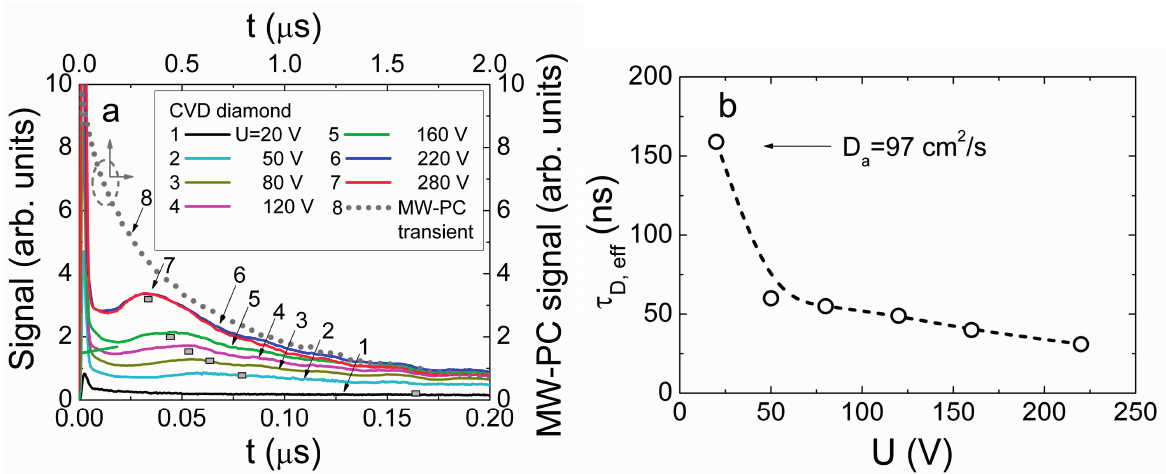
Figure 13. ( a ) Variation of the current transients recorded in the CVD diamond device by changing bias voltage when excess carrier bulk domain is injected through electrode using UV 354 nm light pulses. Dot-curve, ascribed to the top-right scales, represents relaxation of excess carrier density measured by microwave probed photo-conductivity (MW-PC) technique. It should be noted that the time scale (bottom) for the carrier drift-diffusion transients is considerably shorter than that (top) for MW-PC transient; ( b ) Diffusion ascribed effective time τ D , eff (which is determined as a time shift between the current components (peak values i 1, peak and i 2, peak ) within a long scale of transient display) as a function of applied